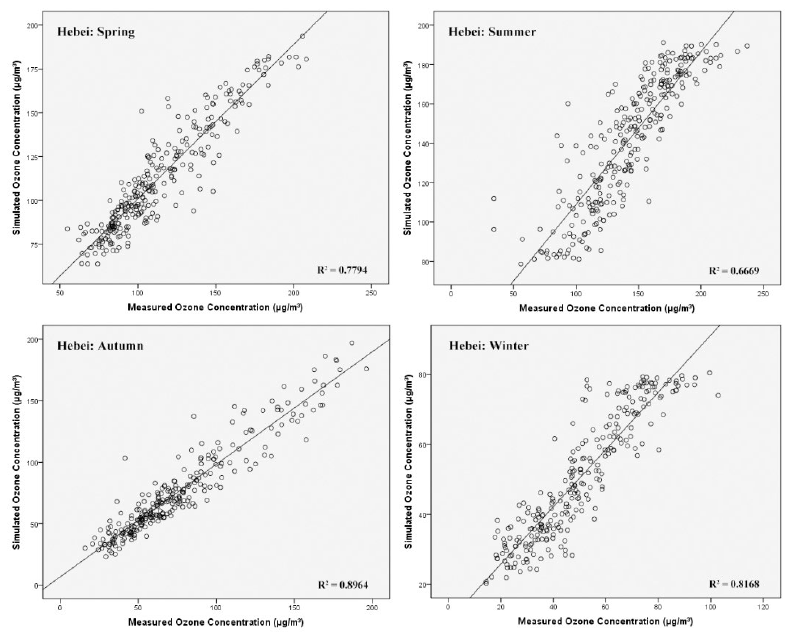
Figure 8. Relationship between the monitored and simulated values of O 3 _8h based on the neural network model in each season in Jing-Jin-Ji region in